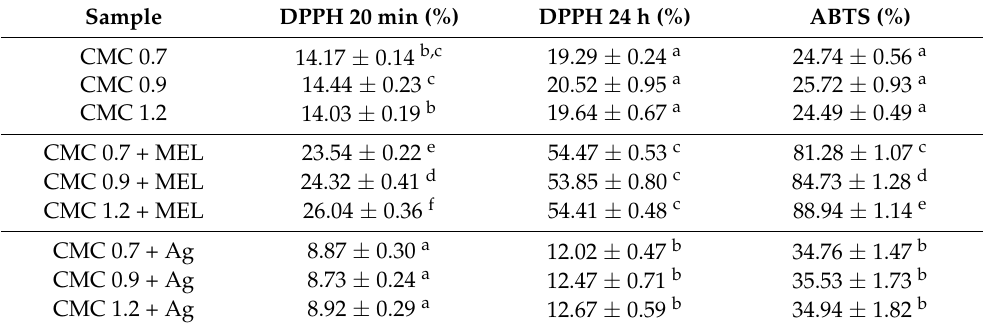
Table 3. Free radical (DPPH and ABTS) scavenging activity of unmodified and modified CMC films.